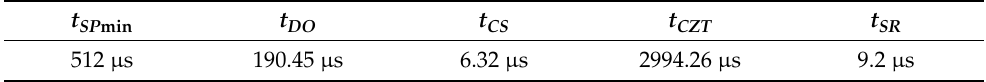
Table 1. The testing of time parameter.